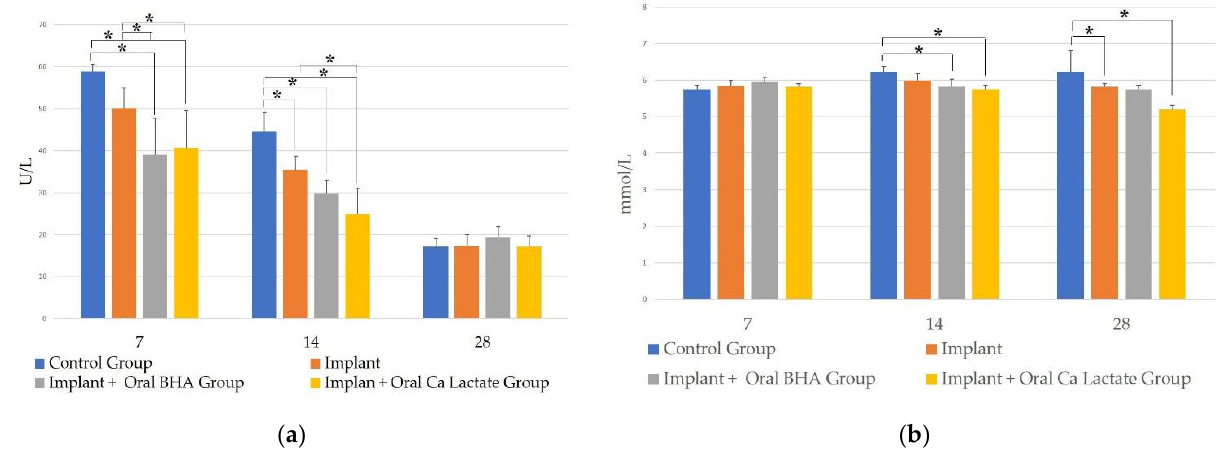
Figure 6. ( a ) BALP level examination results; ( b ) results of examination of calcium levels sign (*) indicates p < 0.05 in post hoc LSD test.